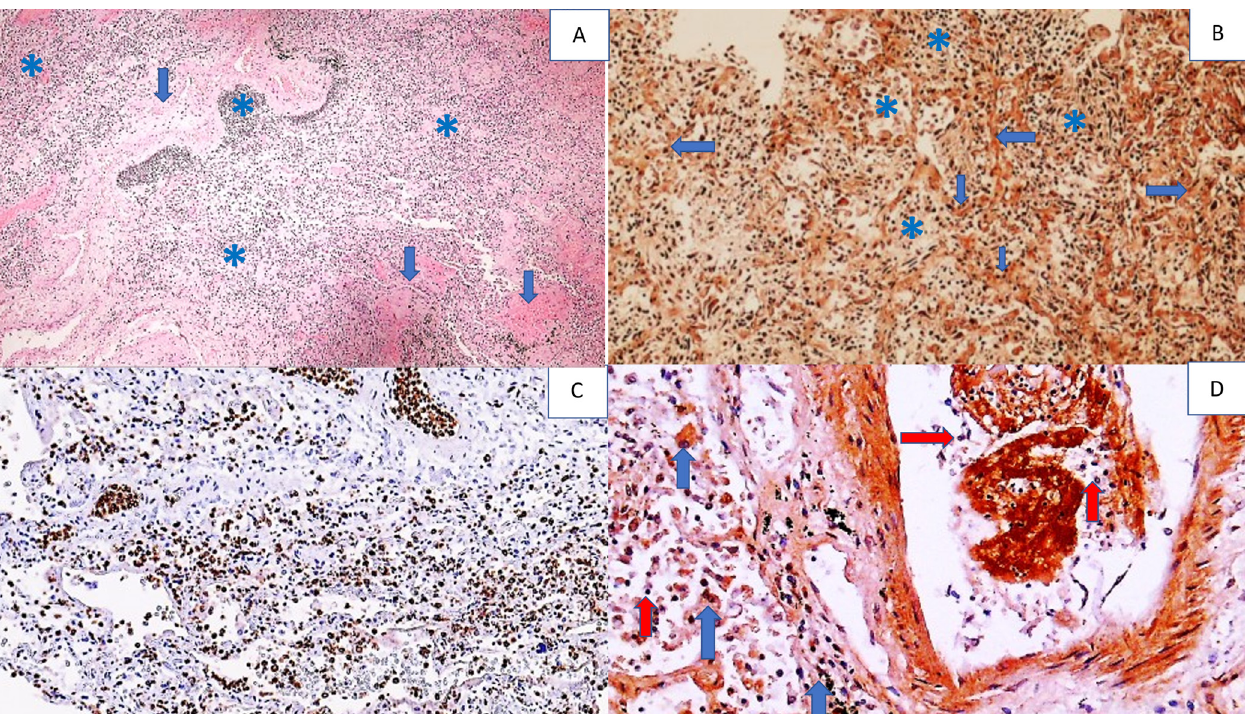
positive reaction to 4-HNE in the pulmonary blood vessel walls (blue arrows) and in the content of the blood vessel (red arrow), in the edematous fluid in the alveoli (black arrow) and hyaline membranes (green arrows), in some inflammatory cells in the blood vessels (blue arrowheads), and in alveolar macrophages (green arrowheads), (DAB, 100 × ). Photo ( B ) shows an immunohistochemically positive reaction to MPO, exclusively in neutrophils that are mainly in the blood vessels of the lungs (arrow) and rarely outside them in the lung tissue, presented as dark brown spots, (DAB, 200 × ). Photo ( C ) shows a strong immunopositive reaction to 4-HNE in a blood vessel wall (arrow), in the content of blood vessels (asterisk), especially in the neutrophils within the blood vessel (red arrows), while being sparsely present in the surrounding edematous brain tissue, visible as dark brown cells (DAB, 400 × ).